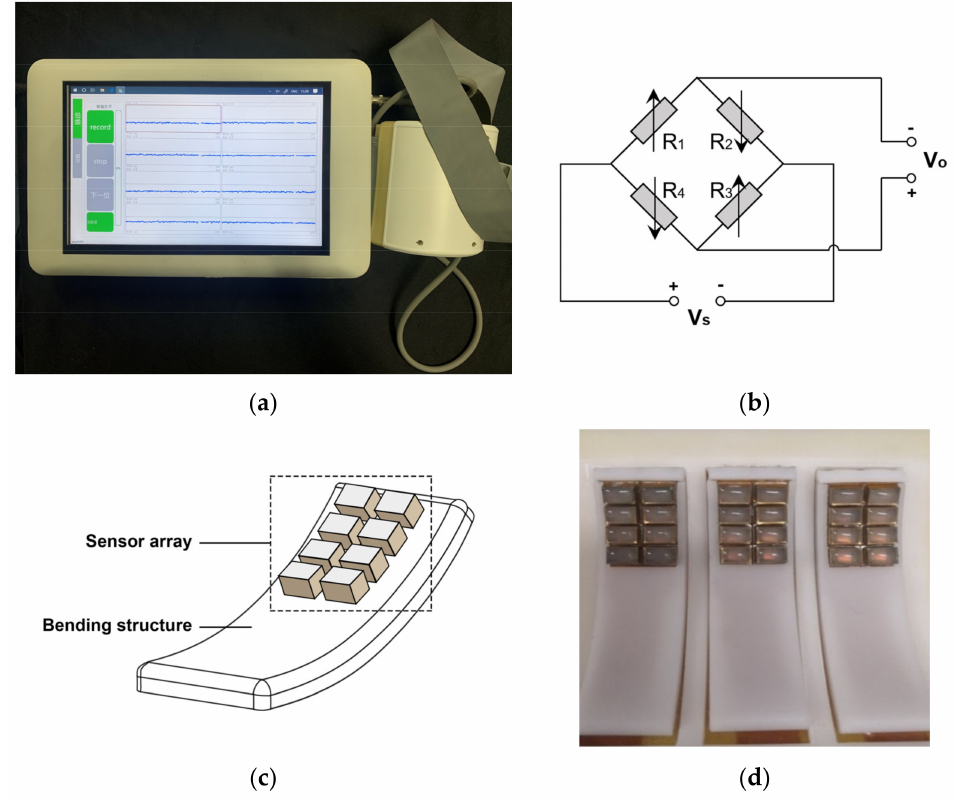
Figure 1. Acquisition device for sensor array signals. ( a ) Photograph of the pulse wave acquisition system. ( b ) Schematic diagram of the circuit structure of the sensor. ( c ) Schematic diagram of the MEMS sensor array. ( d ) Photograph of the MEMS sensor